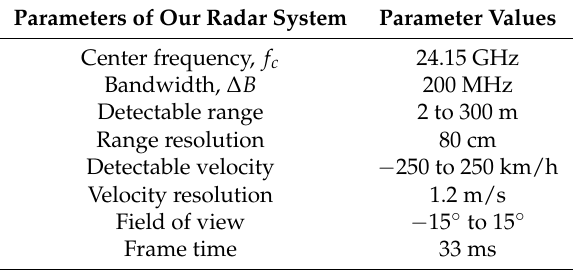
Table 1. Specifications of the traffic monitoring radar